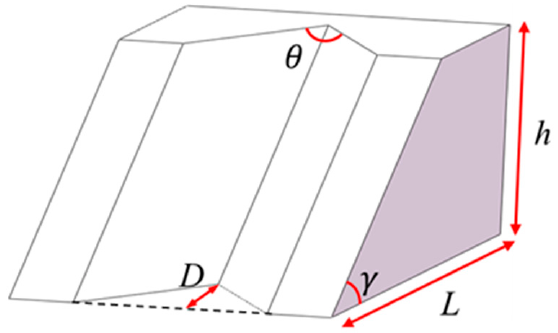
Figure 2. Schematic diagram of the canyon model.